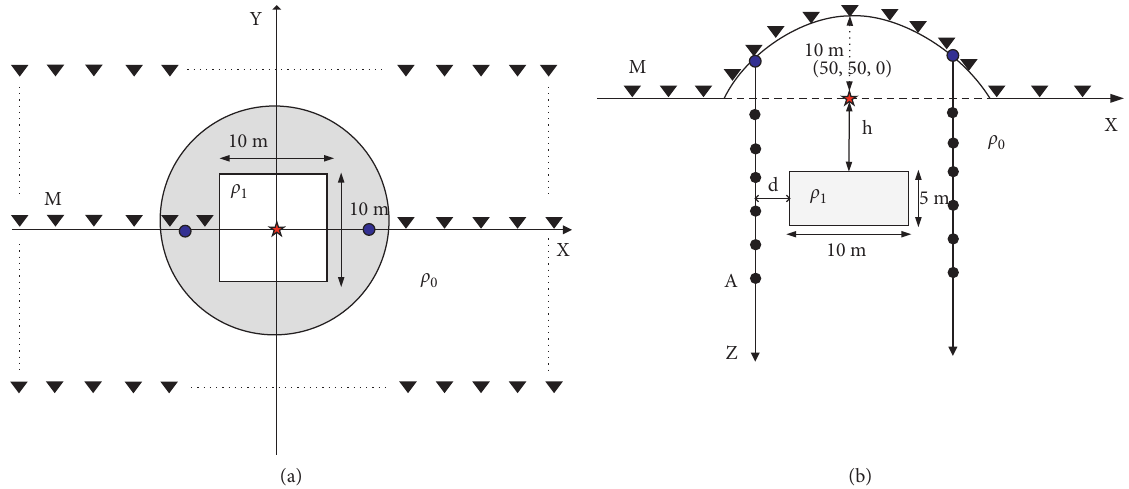
Figure 12: The geometry of mountain topographical model with a cube. (a) XOY plane view; (b) XOZ cross-sectional view.